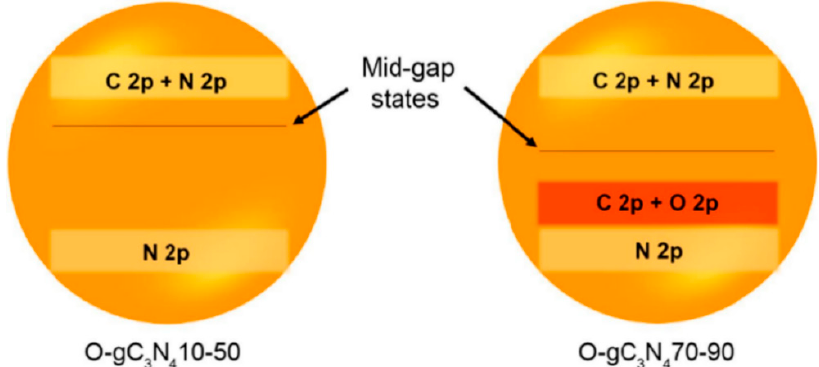
Figure 2. Band structure transformation with increasing oxygen doping level in g-C 3 N 4 . Reprinted from [24], Copyright (2020), with permission from Elsevier.